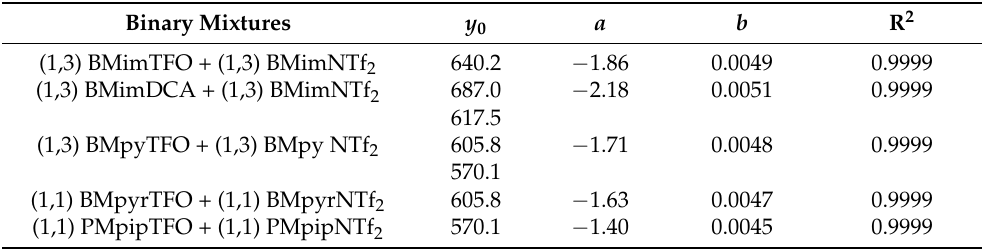
Table 5. Fitting parameters for the fitting (Cp = y 0 + a T + b T 2 ) of the experimental molar heat capacities for equimolar binary mixtures.